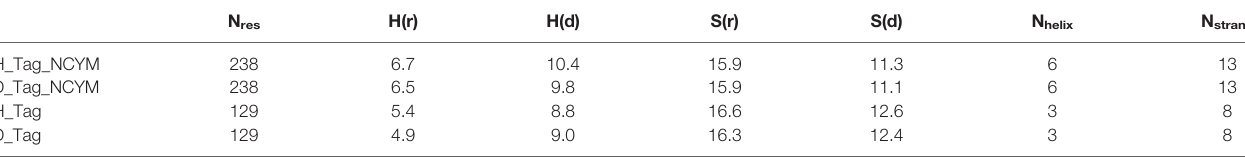
TABLE 1 | Secondary structure content of the NCYM samples used for the VUVCD